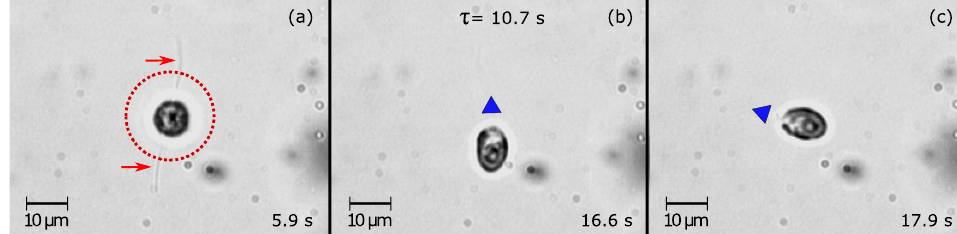
Figure 3. Three frames taken from Video S2 showing induced detachment of the adhered Dunaliella from the top coverslip. ( a ) The adhered Dunaliella highlighted in the red circle is positioned in the path of the laser beam, and at t = 0 s the beam is unblocked. Its adhered flagella are indicated with the red arrows. ( b ) At the moment of the detachment ( τ = 10.7 s), and ( c ) 1.3 s later, the cell shows a different orientation in the optical trap as indicated by the by the blue triangle